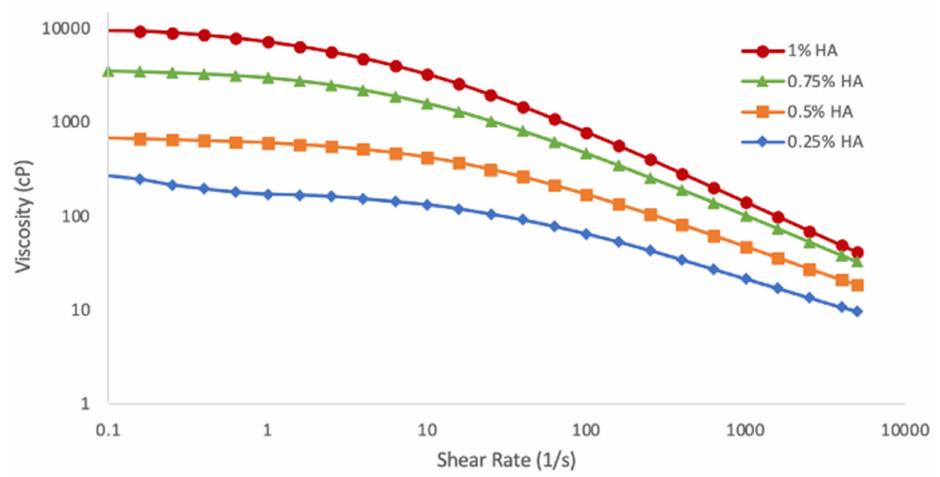
Figure 2. Effect of HA concentration on viscosity vs. shear rate.